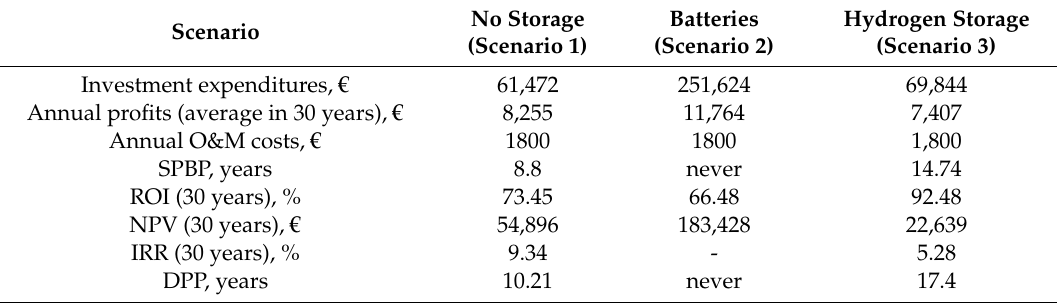
Table 8. Detailed results of economic efficiency analysis.